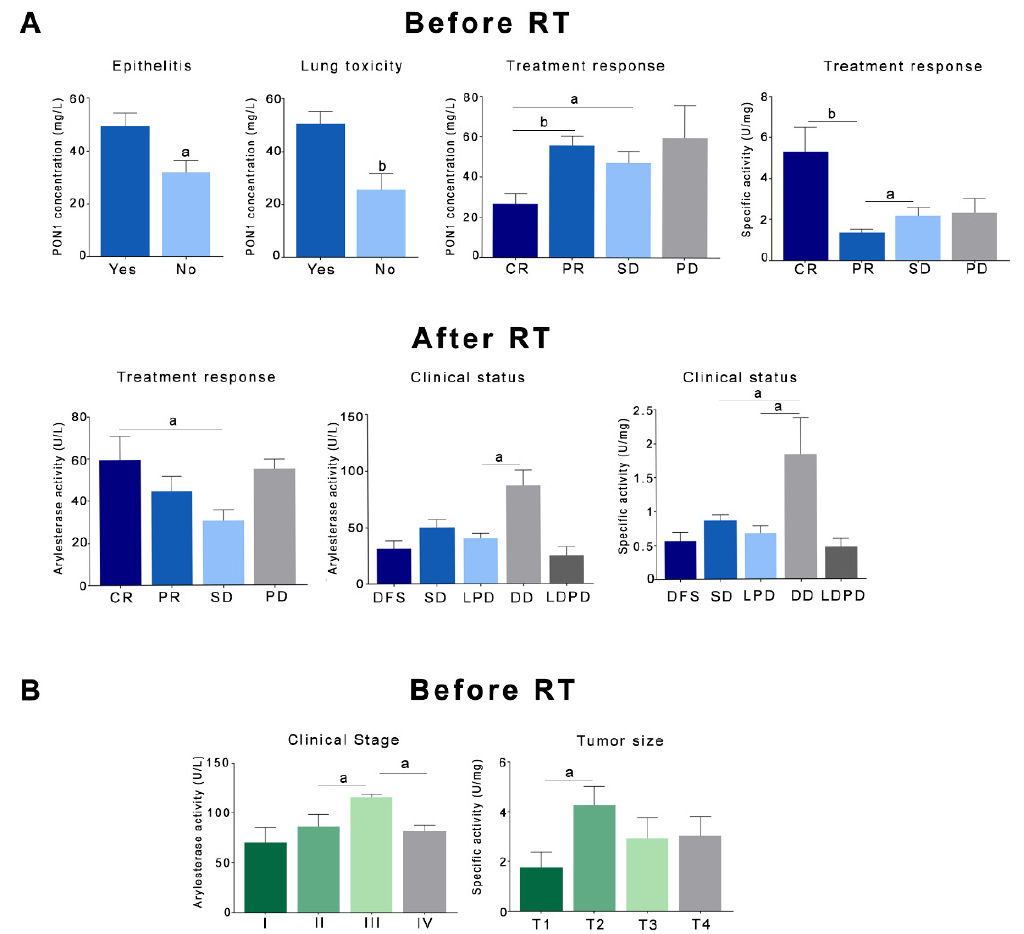
Figure 5. Relationships between paraoxonase-1-related variables and the toxicity to radiotherapy, clinical status, and response to treatment in patients with lung cancer ( A ) or head and neck cancer ( B ). Results are shown as means and standard errors. a p < 0.05, b p < 0.01, by the Mann-Whitney U -test. CR: complete response; DD: distant recurrence of the disease; DFS: disease-free survival; LDPD: loco-regional and distant progression of the disease; LPD: loco-regional progression of the disease; PD: progression of the disease. PON1: paraoxonase-1; PR: partial response; RT: radiotherapy; SD: stabilization of the disease.